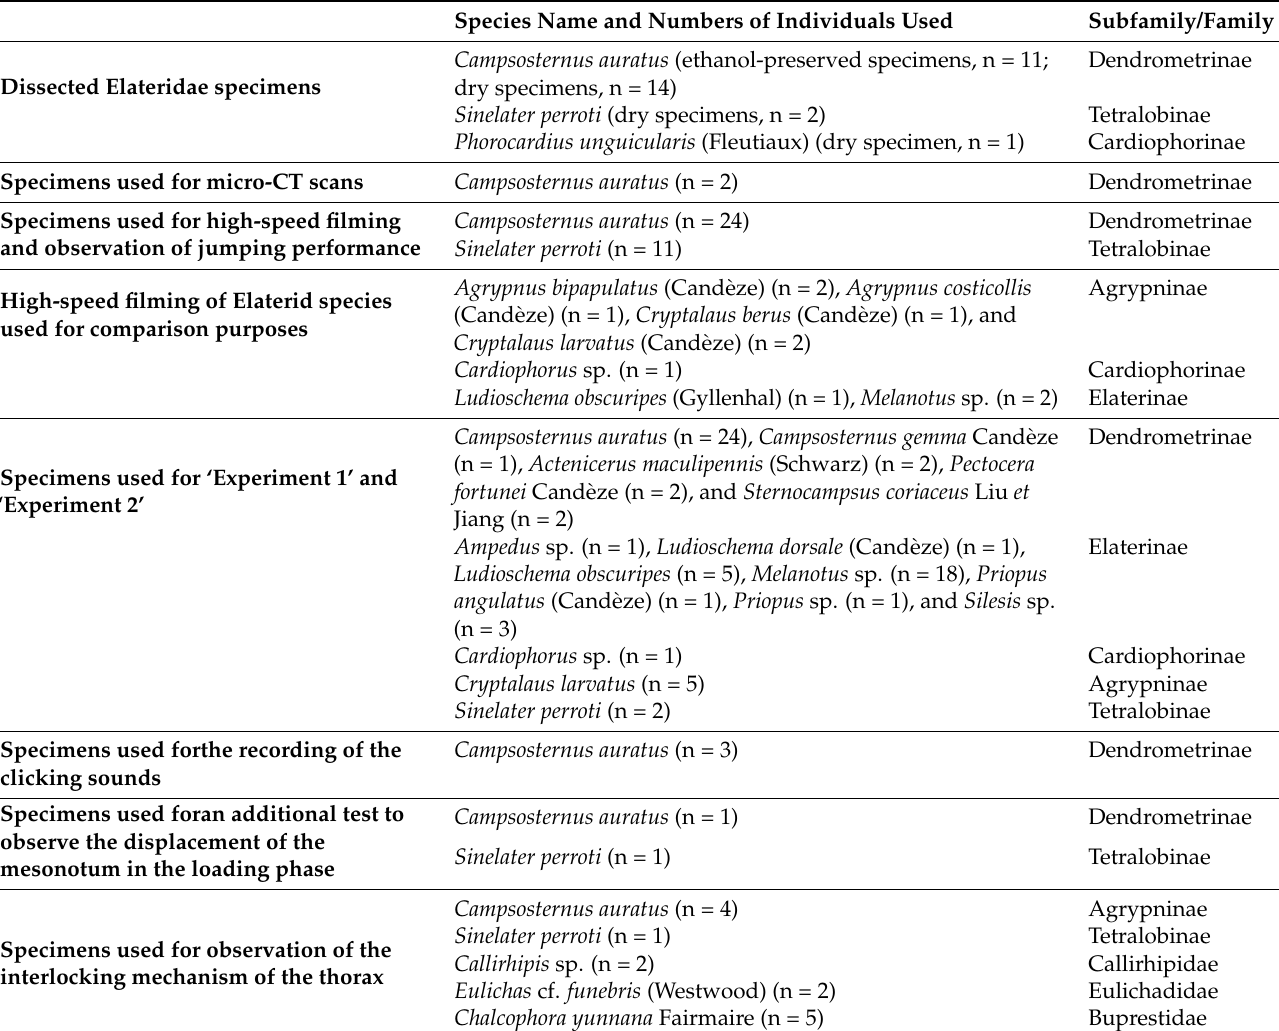
Table 1. Specimen